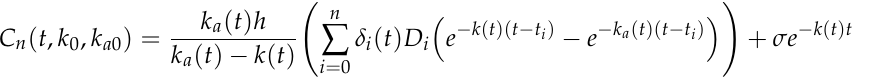
Figure 5. ( a ) Comparison of the revised model predictions (yellow line) with the ultradian rhythm of plasma cortisol observed in subject 2 (blue dots) from the Pulses study following subcutaneous pulsatile CORT infusion (see Materials and Methods). ( b ) Comparison of the revised model predictions (yellow line) with the ultradian rhythm of plasma cortisol observed in subjects 3 (blue dots) from the Pulses study following subcutaneous pulsatile CORT infusion (see Materials and Methods). The revised model assumes discretely varying absorption and clearance rates and the brut-force search method calculates the initial pair of (k 0 , k α 0 ) rates by four cortisol measurements (for instance at timepoints 0, 30 60 and 90 min). We also estimated the relative error of the model predictions across all plasma cortisol data points for subject 2 ( c ) and 3 ( d ). The periodicity of the data allows us to assume that the value of cortisol 24 h later is the same as the first value given, and hence, the error is reduced as we approach the end of that 24-h period. CORT: cortisol, k: clearance rate, k α : absorption rate. Time points of delivery (magnitude of doses): 0 min (2.3 mg/230 μ L), 180 min (2.3 mg/230 μ L), 360 min (0.5 mg/50 μ L), 540 min (0.5 mg/50 μ L), 720 min (4 mg/400 μ L), 900 min (4 mg/400 μ L), 1080 min (4 mg/400 μ L), 1260 min (2.3 mg/230 μ L).